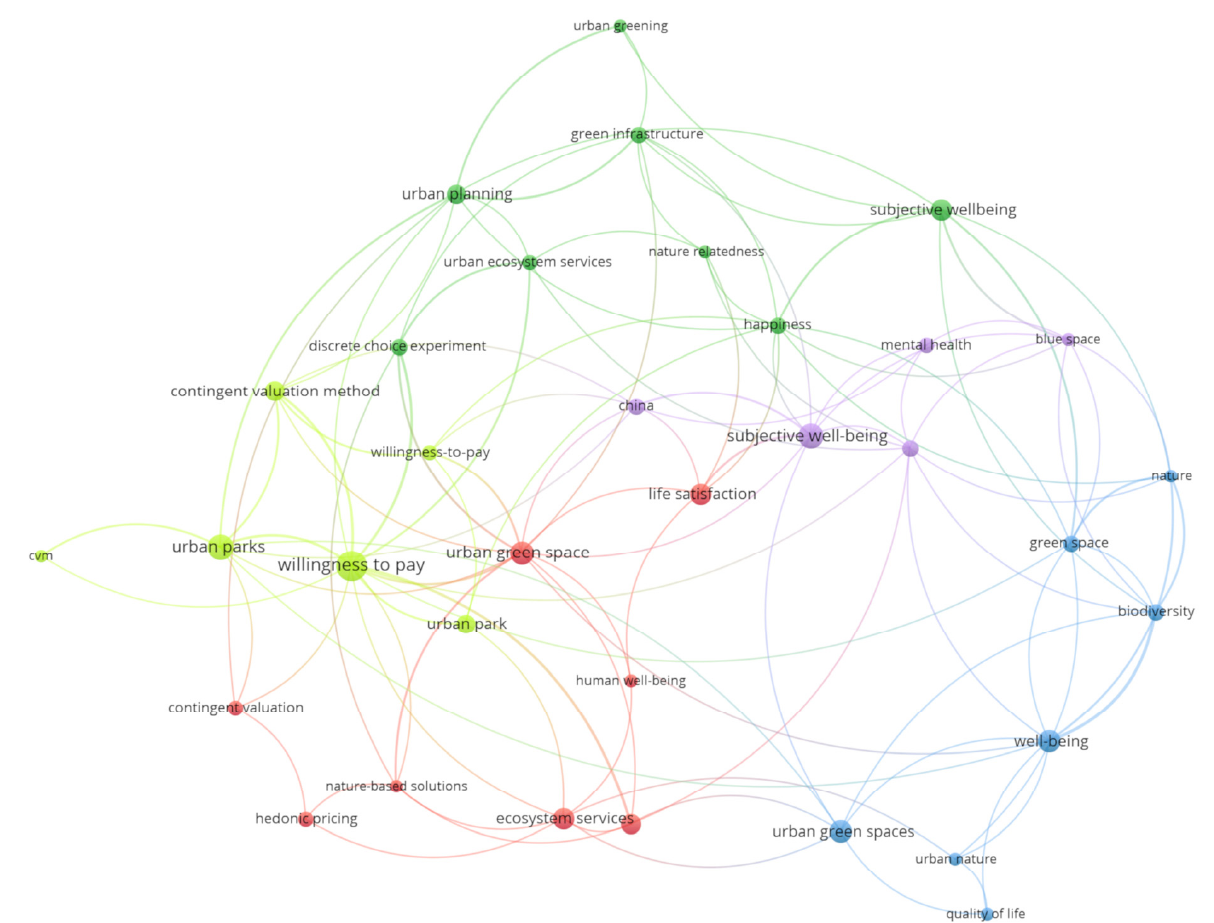
Figure 6. Connection network of keywords (5 clusters).